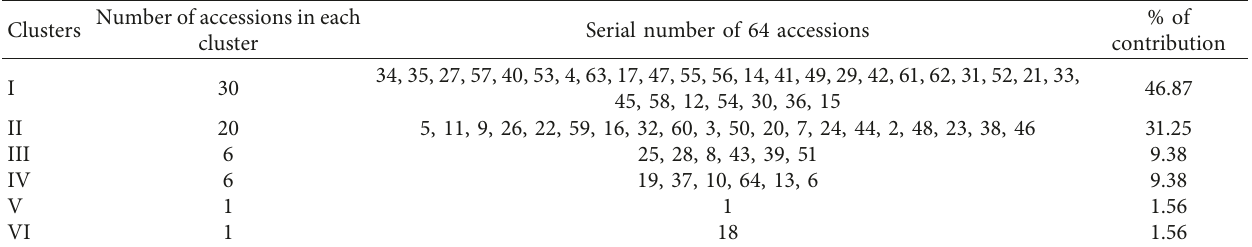
Table 7: Clusters of cassava accessions based on 13 biochemical characters. Number of accessions in each Clusters cluster